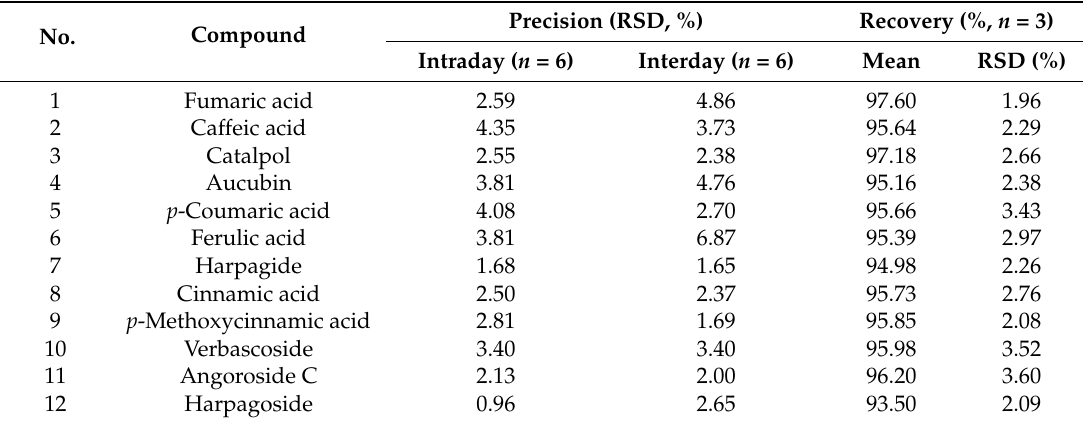
Table 3. Precision and recovery of the 12 investigated compounds.